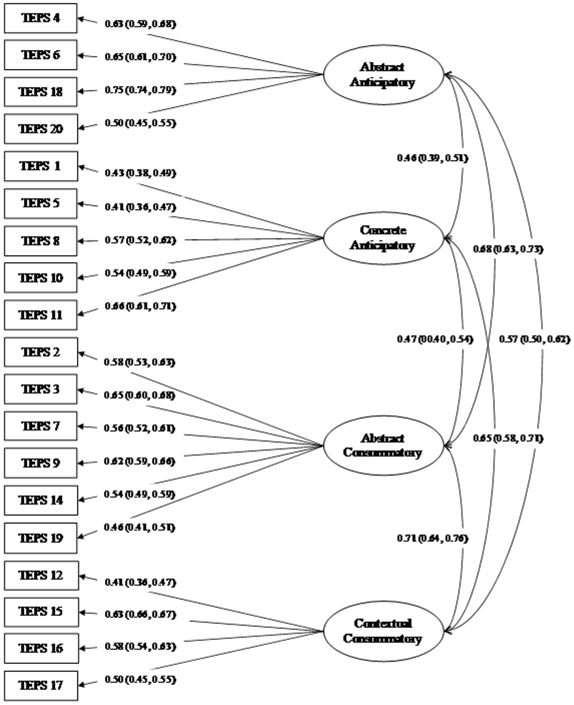
Four-factor model of the Chinese translated TEPS in the validation sample – Factor loadings and correlations between factors estimated by the Satorra-Bentler (SB) method, and their means (which is the same as the estimates by the SB method at 2 decimal places) and 95% confidence intervals (in brackets) estimated by the Bollen-Stine bootstrapping method.